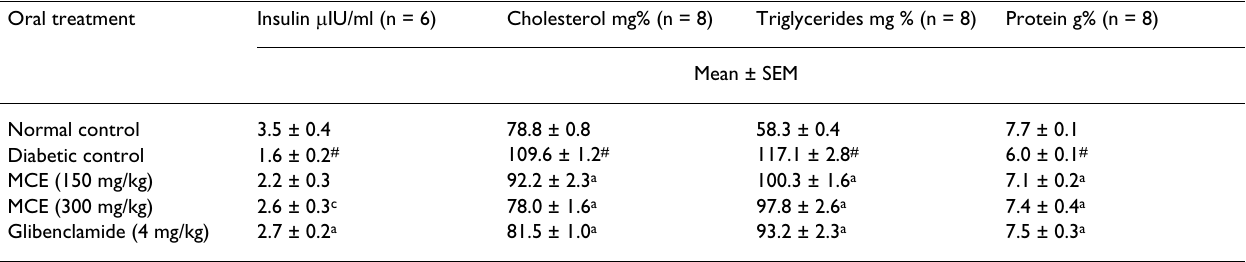
Table 1: Effect of Momordica charantia extract on the serum insulin, cholesterol, triglyceride and total protein levels of alloxan diabetic rats Oral